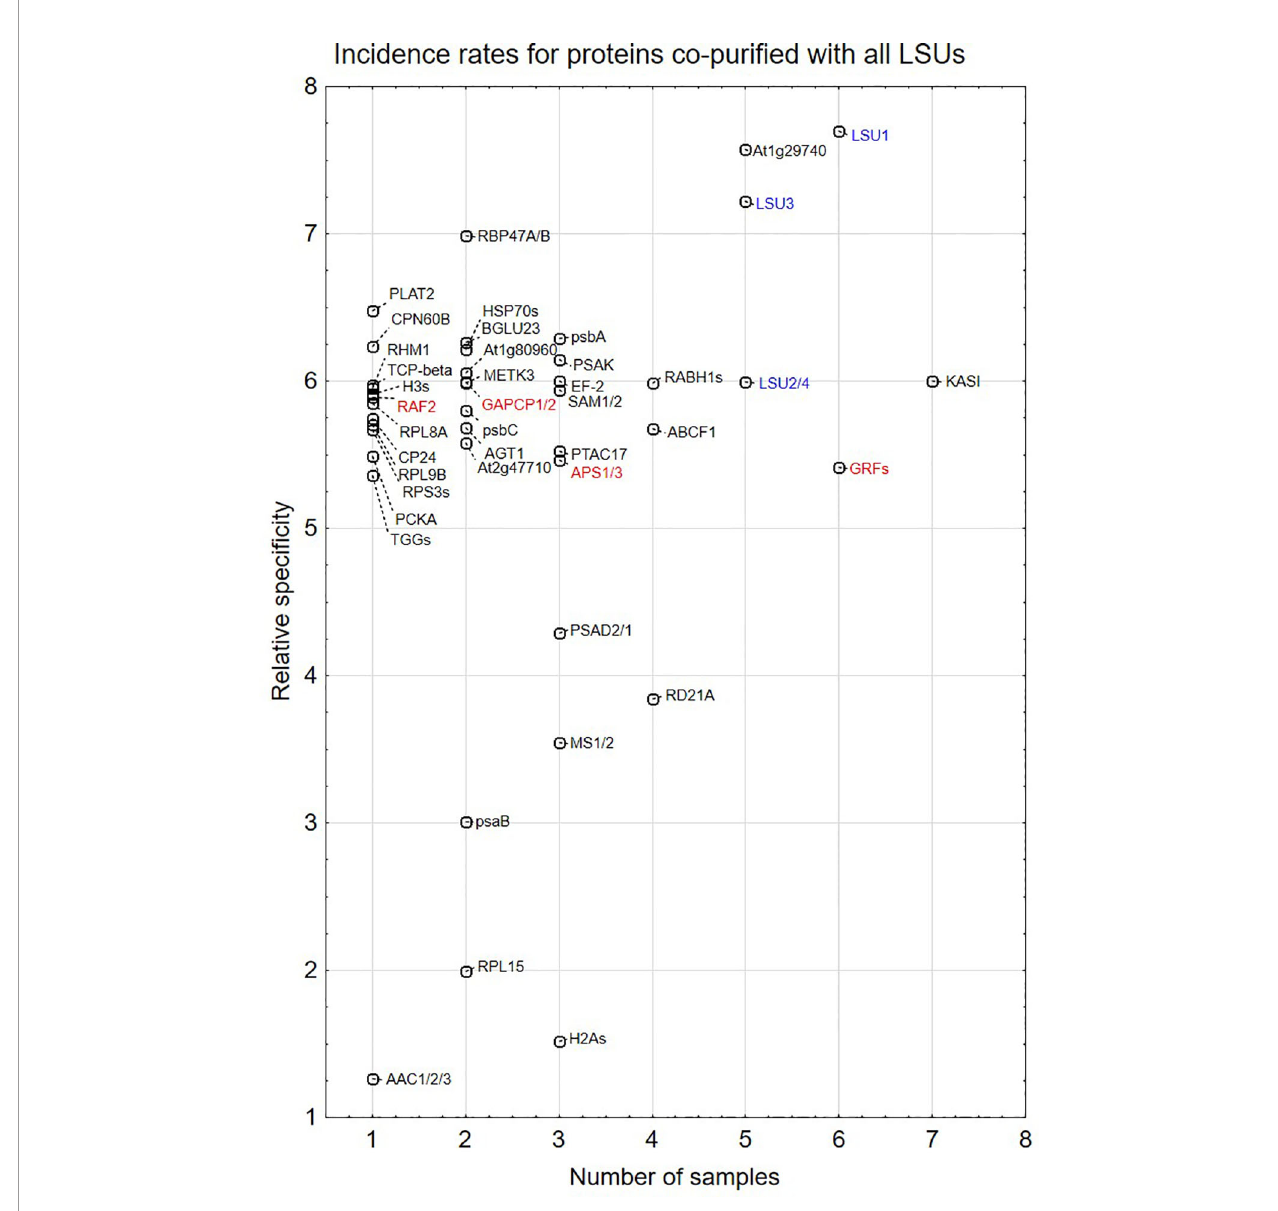
FIGURE 5 | Semi-quantitative plots indicating incidence rates for individual proteins co-puri fi ed with all four LSU proteins in four growth conditions (16 biological samples). In some cases, MS results do not distinguish which protein from the family was present in the extract. This is indicated by a “ / ” or “ s ” at the end of the name. The proteins are listed in Supplementary Table 1A . LSUs detected in the extracts are in blue. Proteins selected for direct interaction veri fi cation with LSUs are in